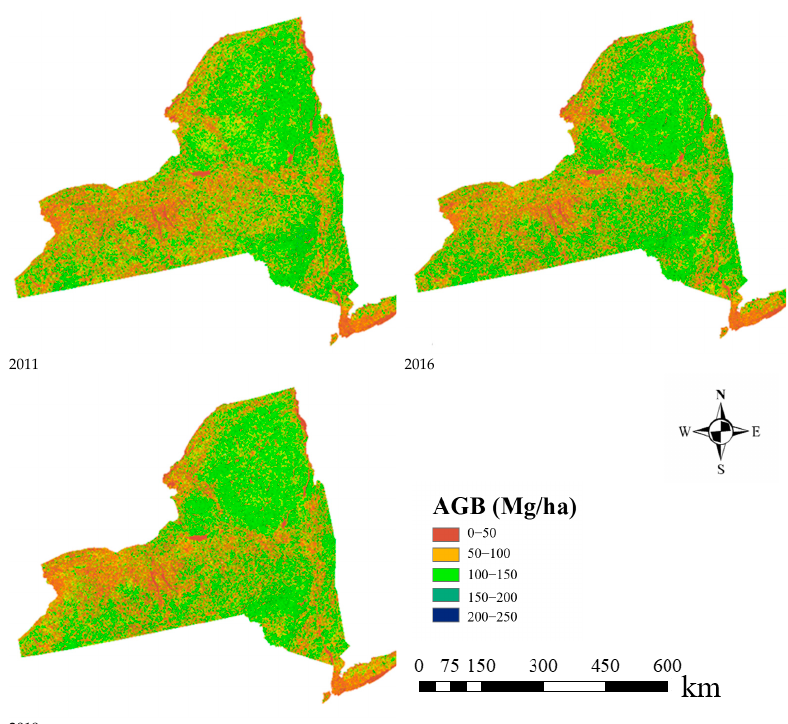
Figure 4. NYS object-based historical AGB mapping using random forest regression model in GEE and Landsat imagery. Loss, gain, and unchanged areas are demonstrated in Figure 5 for the 5-year incre- ment. Areas with gain are shown in green, loss in red, and unchanged regions in blue. For the 2001–2006 time period, green areas are more than red areas, which indicates an in- crease in the amount of AGB in the year 2006. In the 2006–2011 change map, the loss seems to be the dominant phenomenon (Figure 5). For the 2011–2016 AGB change map, both loss and gain are evident. Within the time span of 2016–2019, it is hard to see significant loss or gain. In order to analyze further the loss/gain of AGB, specific regions across NYS were selected (Figures 6 and 7) and investigated according to the US National Maps Attributing Forest Change: 1986–2010 [45].